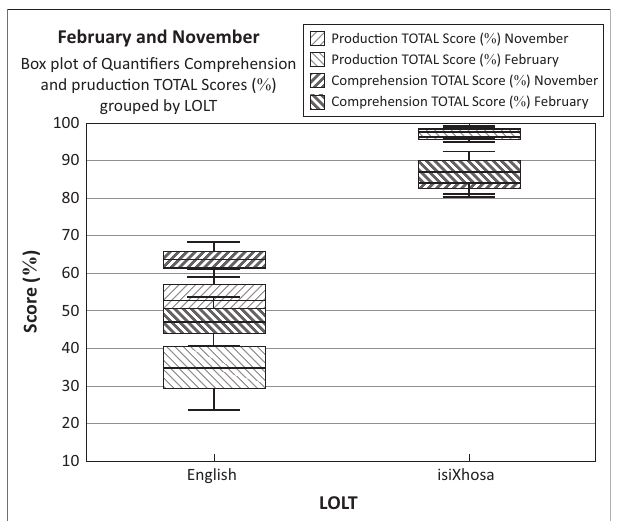
FIGURE 1: The comprehension and production total scores of all quantifier types ( % ) per language of learning and teaching.